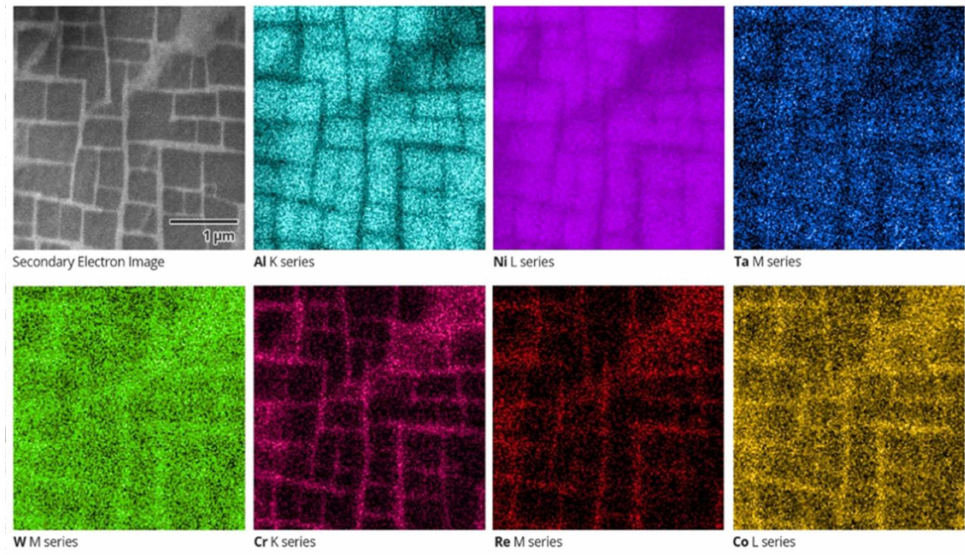
Figure 1. Secondary electron image and energy-dispersive X-ray spectroscopy (EDS) maps of single crystal Ni-base superalloy CMSX-4. The scale of all images is the same as shown in the Secondary Electron Image, and the corresponding elements are